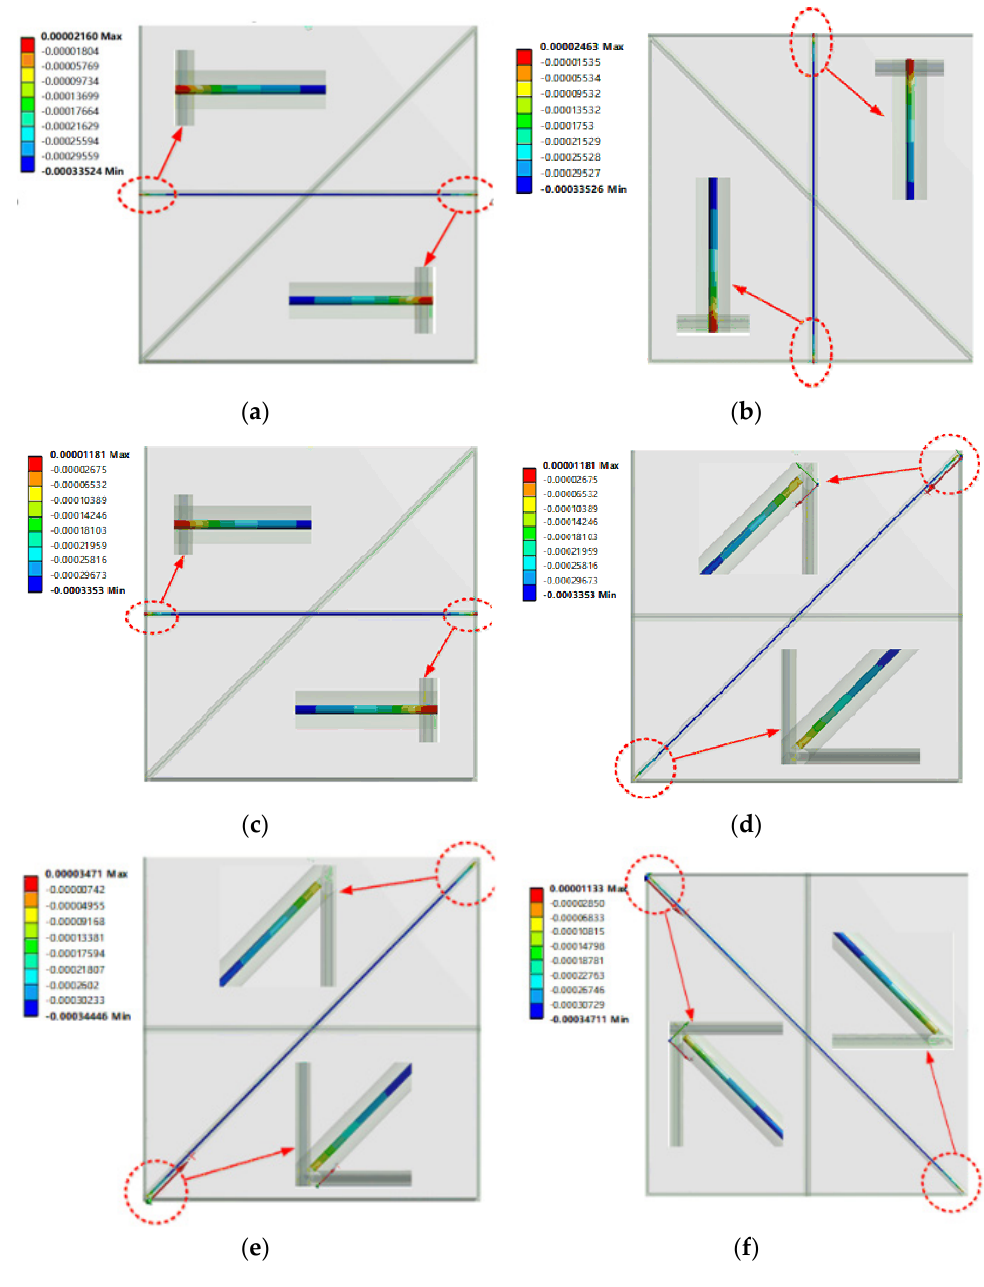
Figure 10. Axial strain distribution of each optical fiber under 50 MPa hydrostatic pressure (The value on the graph is ε ). ( a ) Strain of optical fiber 1; ( b ) Strain of optical fiber 2; ( c ) Strain of optical fiber 3; ( d ) Strain of optical fiber 4; ( e ) Strain of optical fiber 5; ( f ) Strain of optical fiber 6.